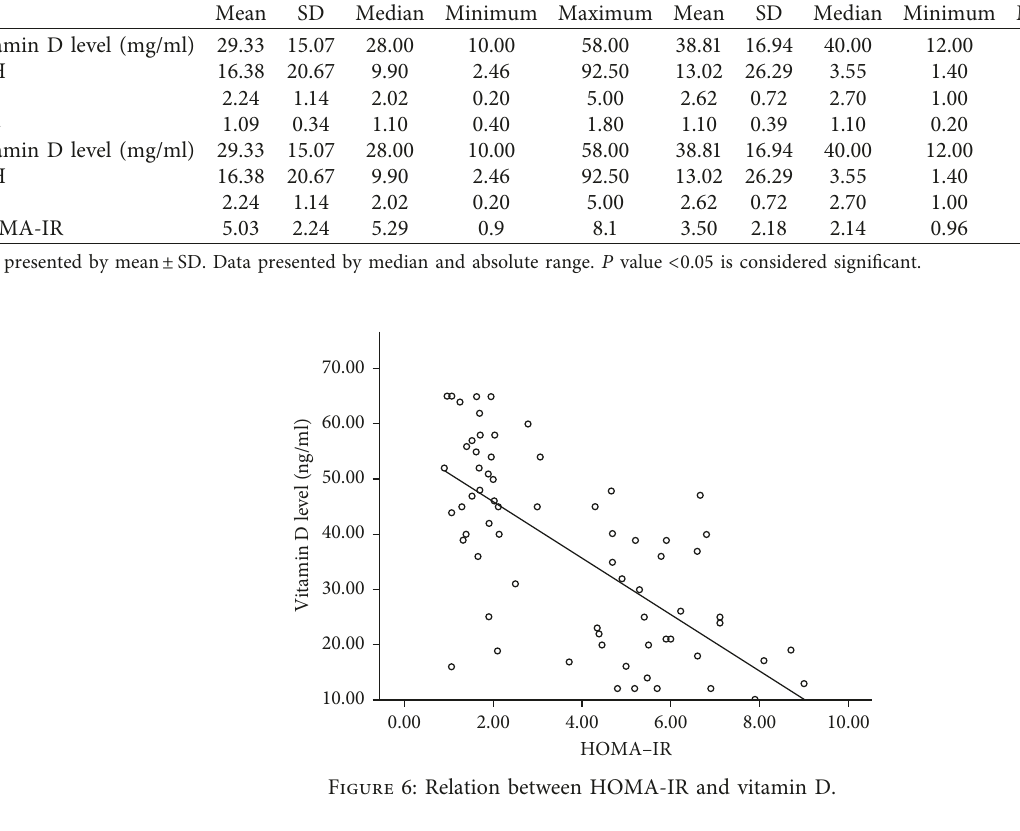
Table 7: Presence of nodules in thyroid gland in relation to vitamin D level, thyroid hormones, and HOMA-IR. Nodularity Yes No P value Mean SD Median Minimum Maximum Mean SD Median Minimum Maximum Vitamin D level (mg/ml) 29.33 15.07